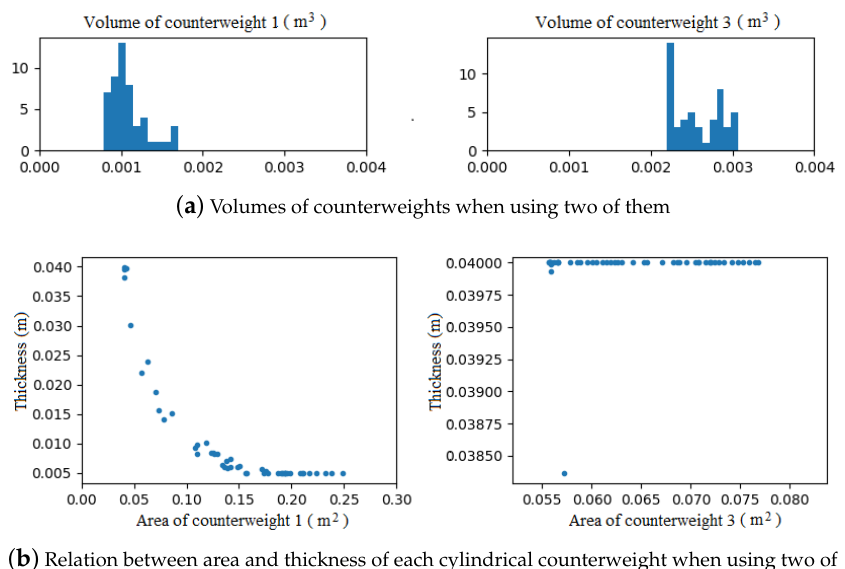
Figure A2. Parameters used to analyze the dimension of each counterweight when using two of